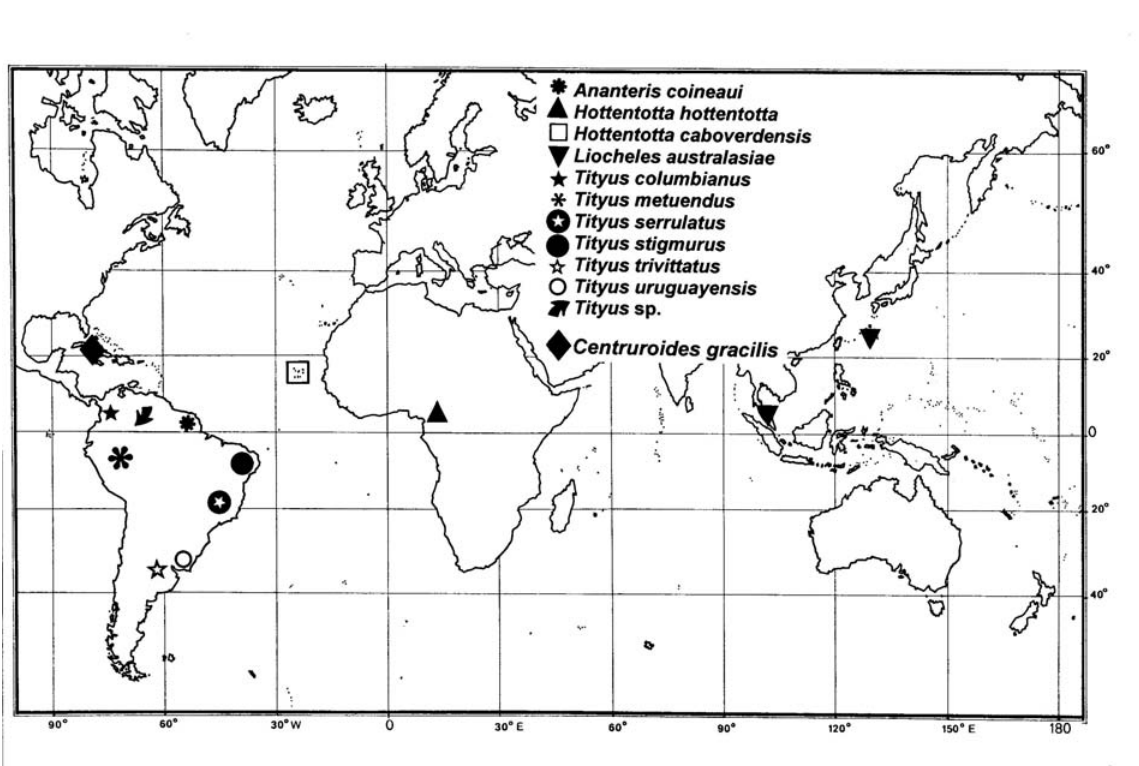
Figure 13. Map showing the distribution of parthenogenetic populations of scorpions.